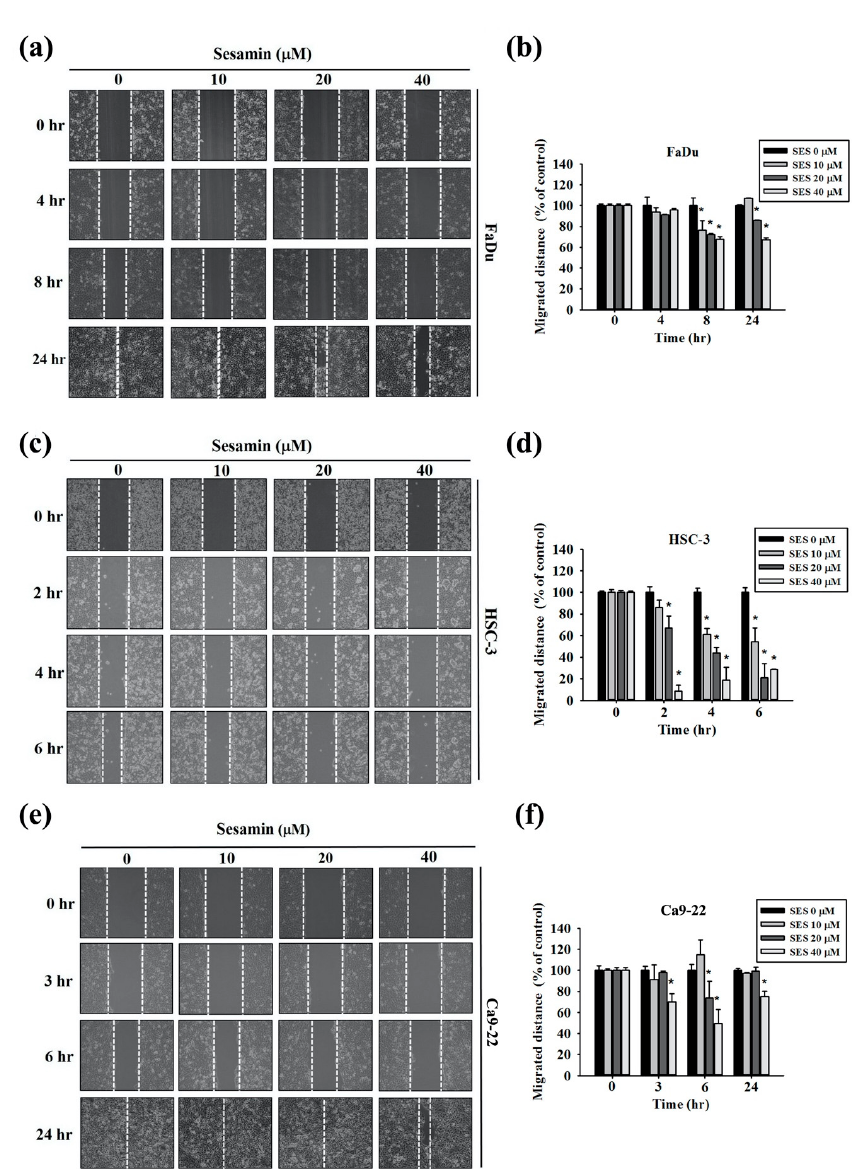
Figure 2. Cell motility according to the wound-healing assay of human oral cancer cells following sesamin treatment. ( a ) FaDu cells were seeded into 6-well plates in appropriate numbers. Photographs show wound closure following treatment with sesamin (SES) (0, 10, 20, or 40 μ M) for 4 and 8 h. ( b ) The quantitative analysis shows the FaDu cell movement distance. ( c ) HSC-3 cells shown at the different time points of 2, 4, and 8 h by wound closure photographs and ( d ) the quantitative results. ( e – f ) Ca9-22 cells shown at 3, 6, 24 h by wound closure photographs. The values represent the means ± SD of at least three independent experiments. * p < 0.05, compared with the control group.